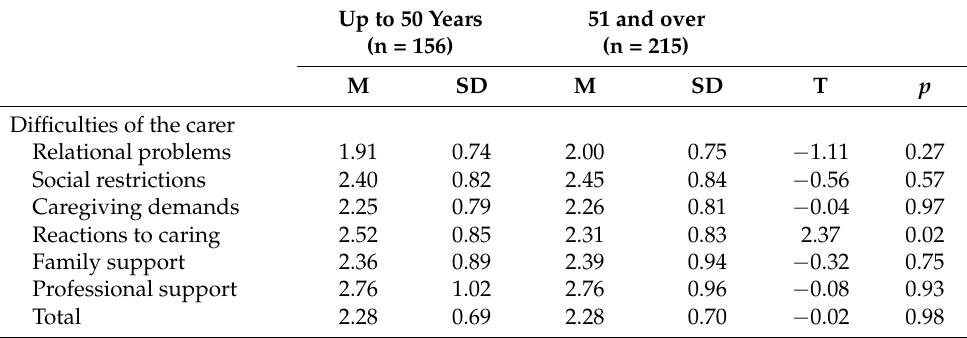
Table 11. Results of the study of caregiver difficulties as a function of age of participants.